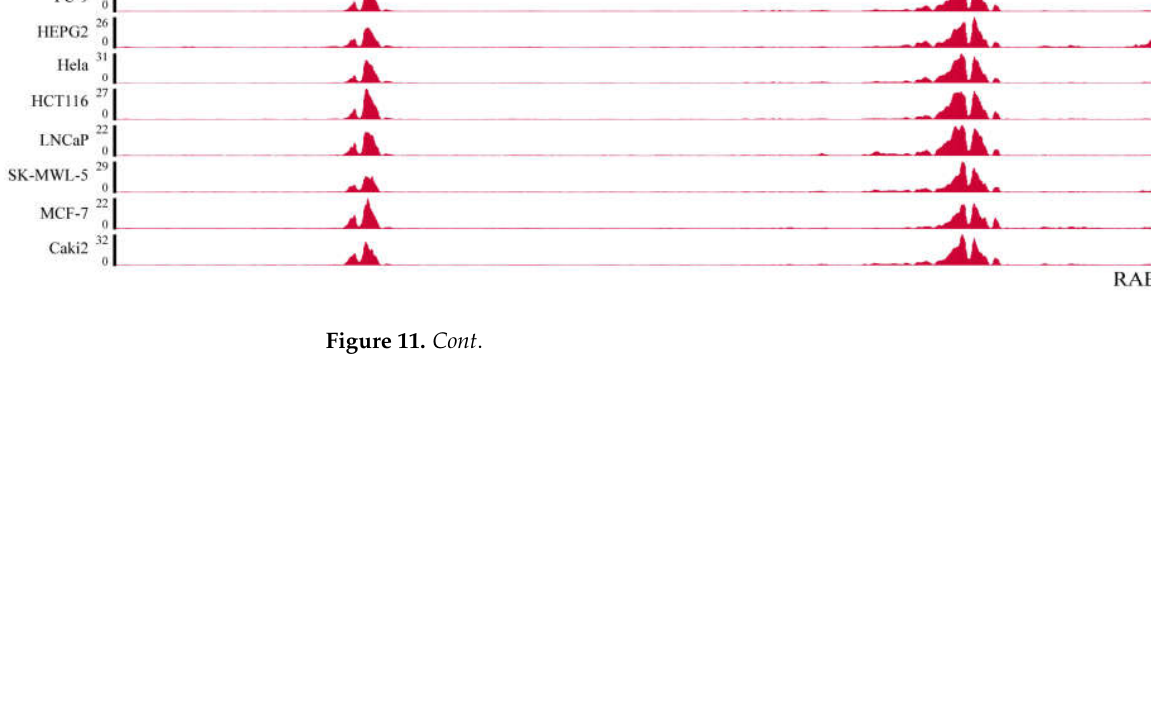
Figure 11. The effect of super enhancer on RAB42 expression. ( A ) ChIP-seq profiles of H3K27ac signal in RAB42 gene loci in different tumor cells. ( B ) The relative RAB42 expression was deter- mined in gastric cancer cells by qPCR. ( C ) The relative enrichment levels of H3K27ac to RAB42 gene loci by ChIP-qPCR. ( D ) Correlation between BRD4 and RAB42 expression in STAD using the GEPIA database. ( E ) The relative enrichment levels of BRD4 to RAB42 gene loci by ChIP-qPCR. ( F ) The relative RAB42 expression after the treatment with JQ1 (1uM) and I-BET-762 (2uM) by qPCR. ( G ) The relative RAB42 expression after BRD4 knockdown by qPCR. * p < 0.05, ** p < 0.01, *** p < 0.001, and **** p < 0.0001.